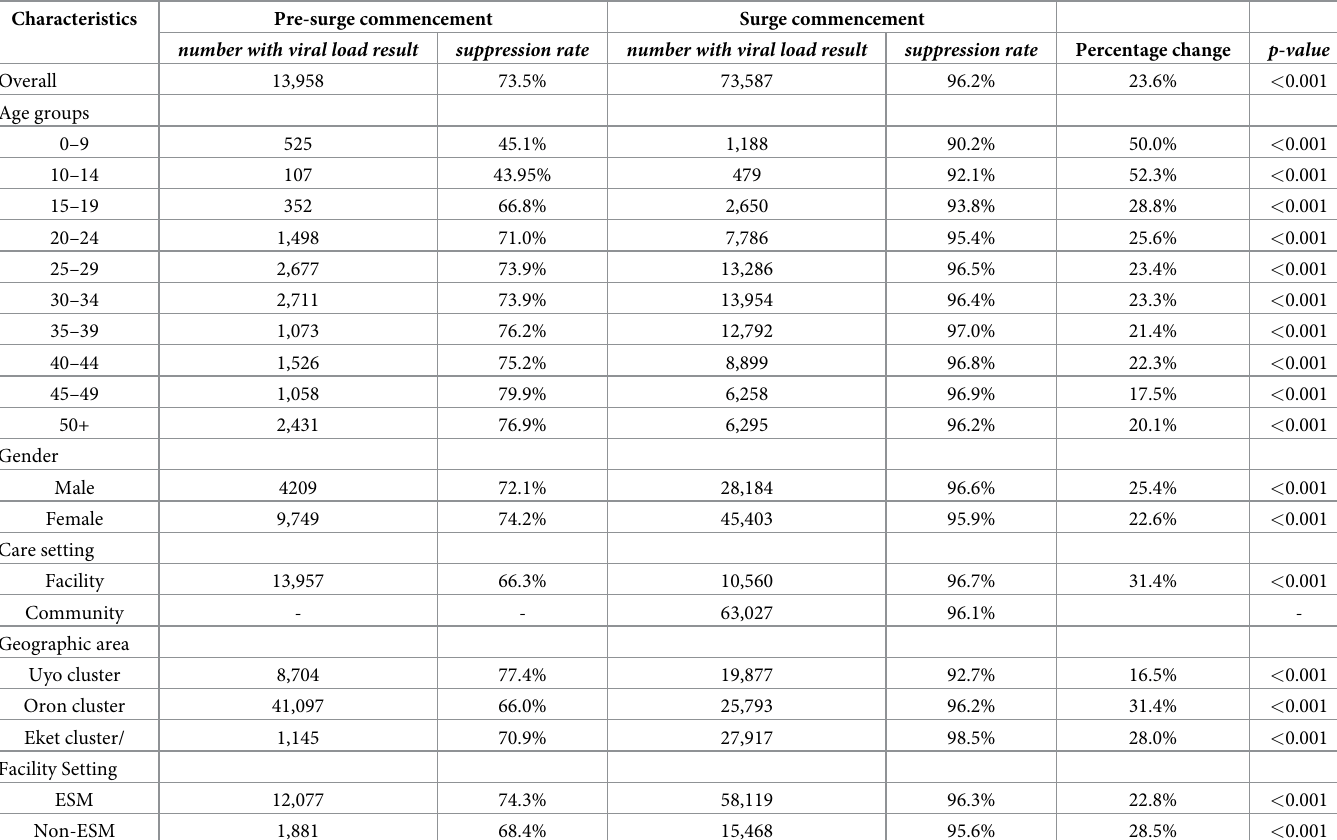
Table 7. Participant characteristics and viral suppression by intervention